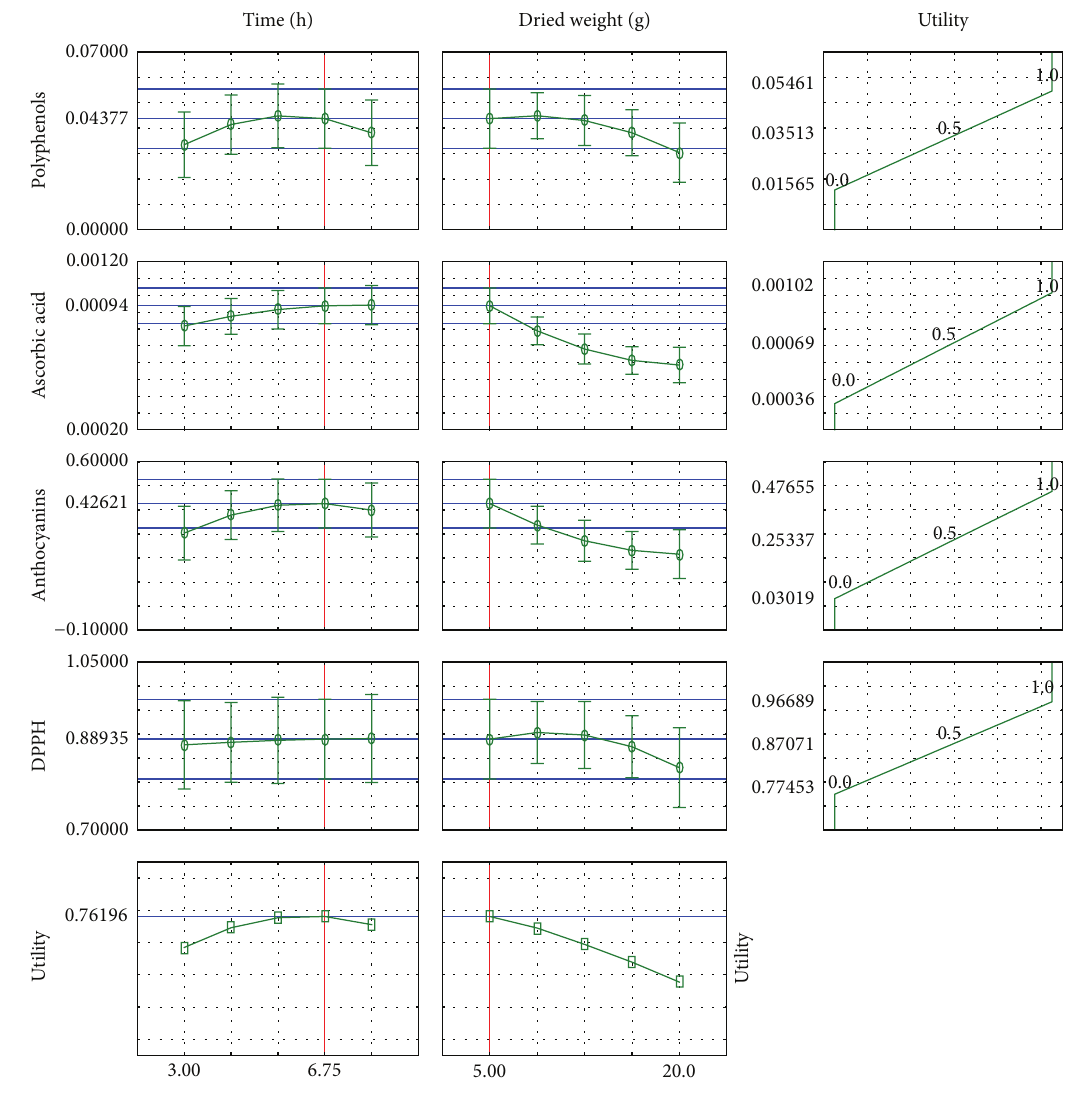
Figure 4: Response surface regression profile for dog rose extract.